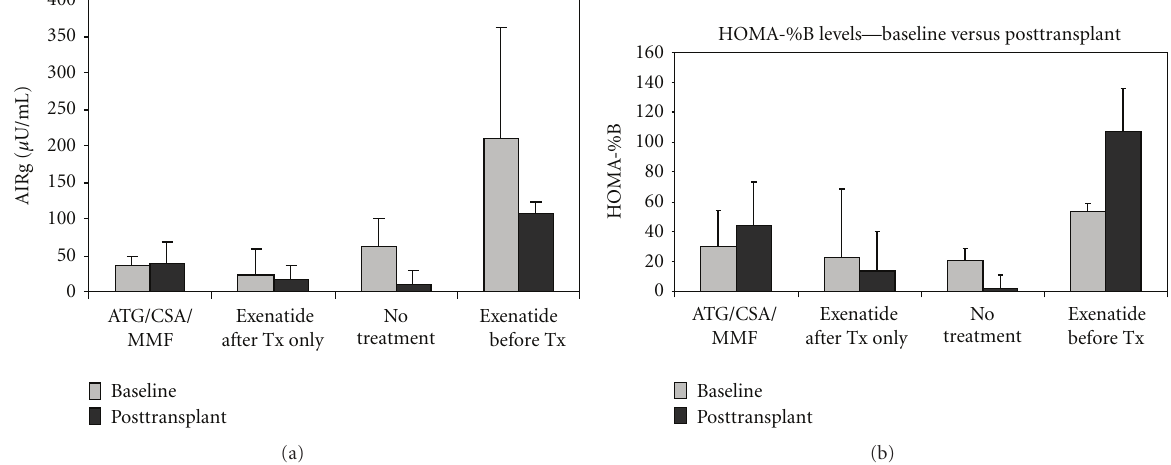
Figure 4: Acute insulin response to glucose ( μ U/ml) as a measurement of first phase insulin secretion following i.v. glucose administration (a). Beta cell function as determined by homeostasis model assessment (HOMA-%B) (b). Untreated animals and animals treated with exenatide after transplant only were tested at day 0 and at day 10. ATG/CSA/MMF and exenatide pre-treatment groups were tested at day 0 and day 90.